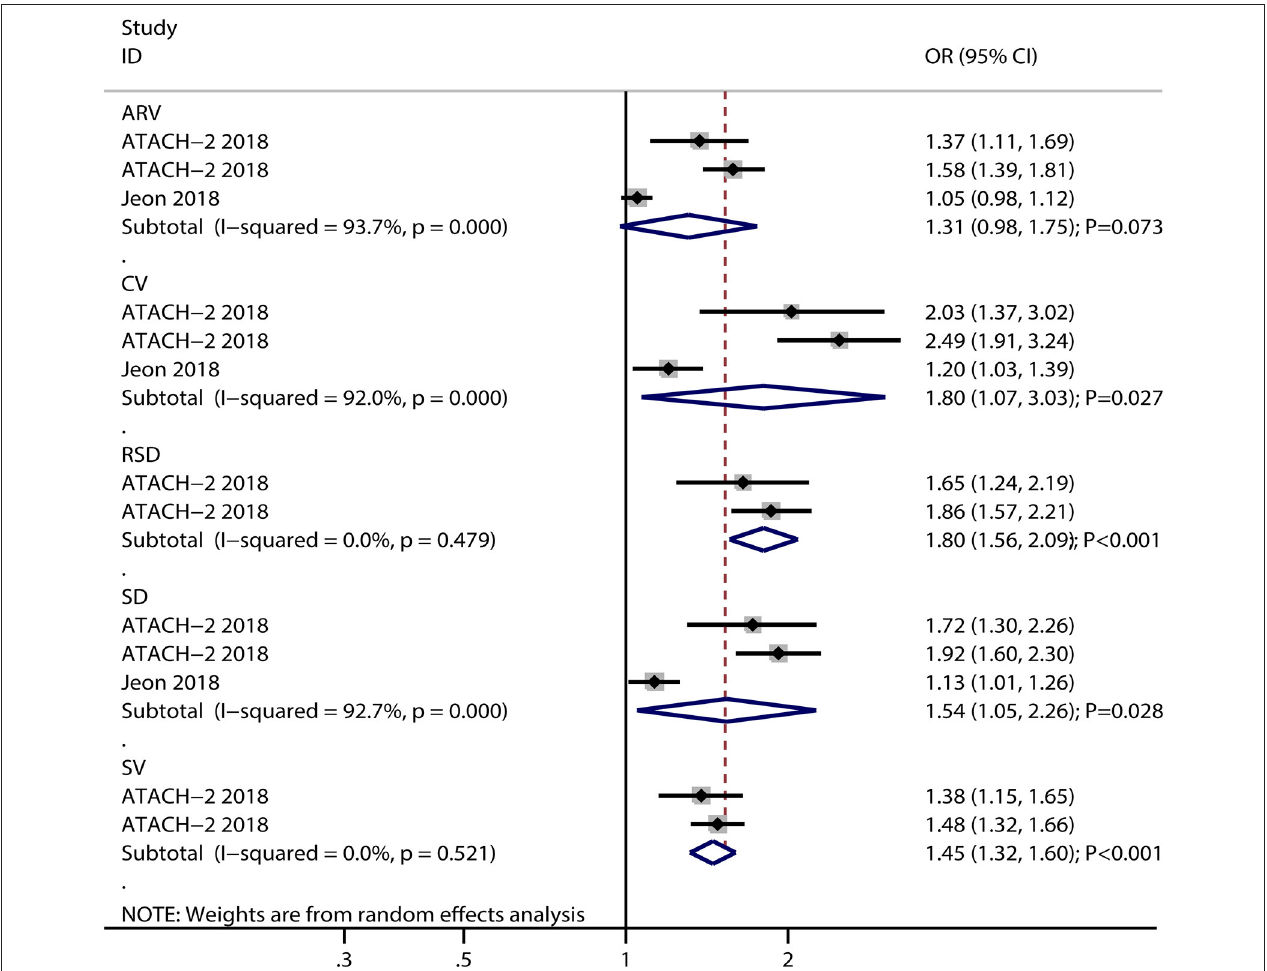
FIGURE 3 | Forest plot for the association of systolic BP variability with poor functional outcome based on crude